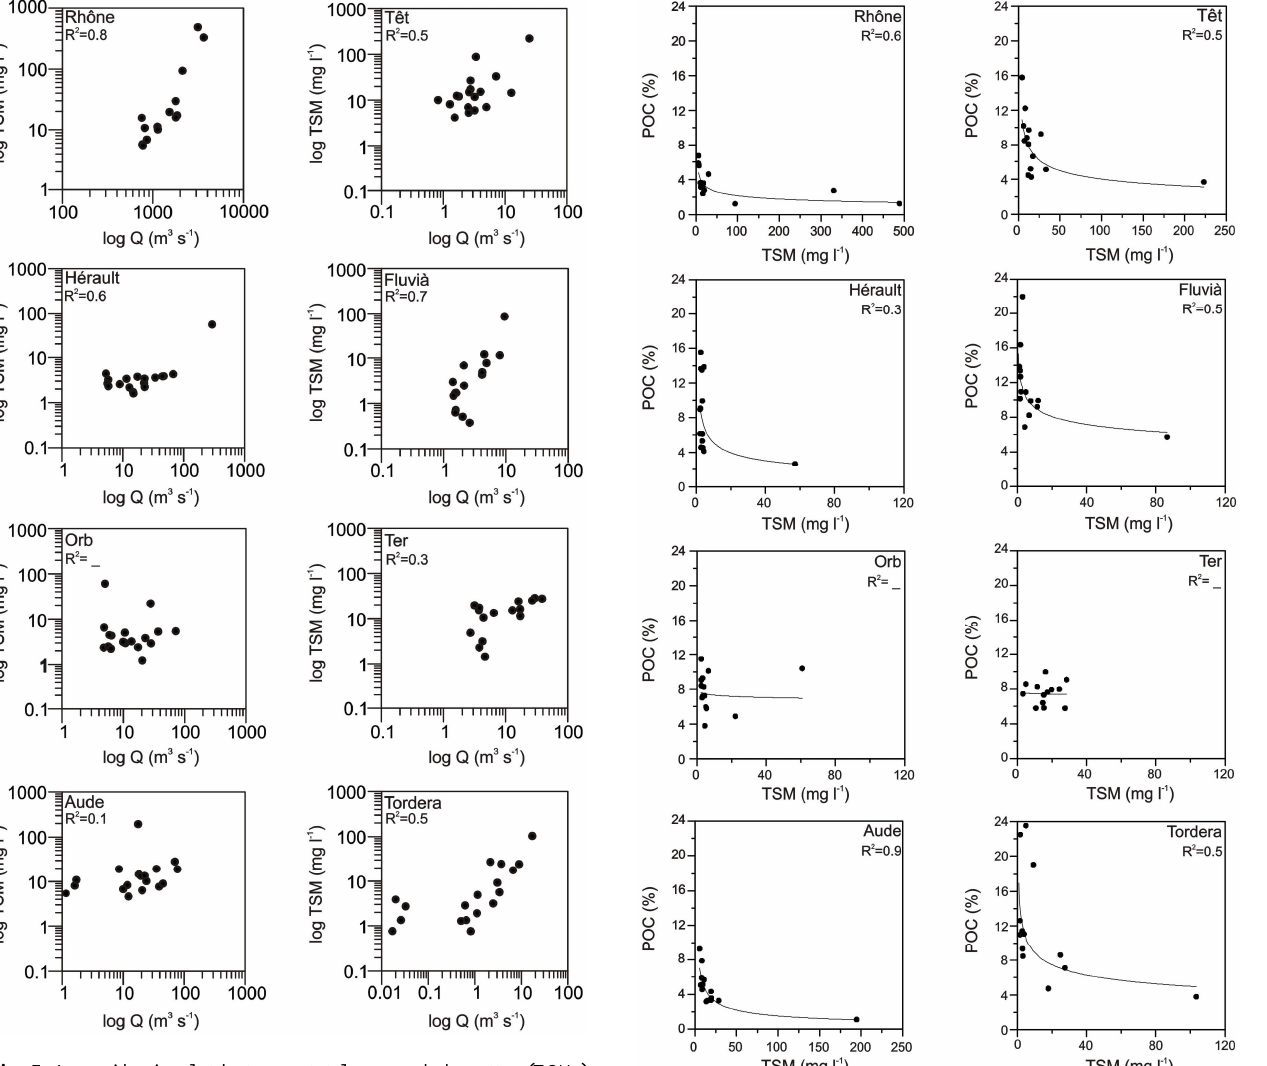
Figure 5. Logarithmic plot between total suspended matter (TSM) concentration and average daily water discharge (Q) with R 2 values obtained using the sediment rating curve: TSM= a·Q b , where a and b are regression coefficients.